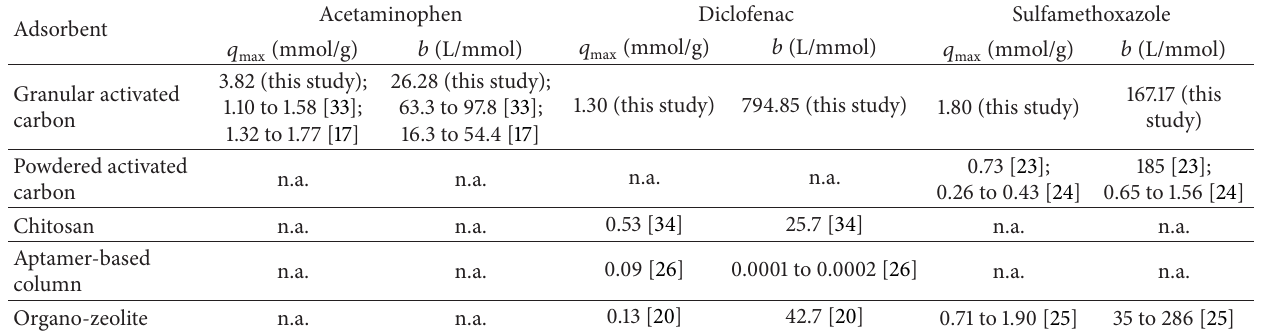
Table 4: Comparison of Langmuir isotherm of acetaminophen, diclofenac, and sulfamethoxazole onto various adsorbents. Adsorbent